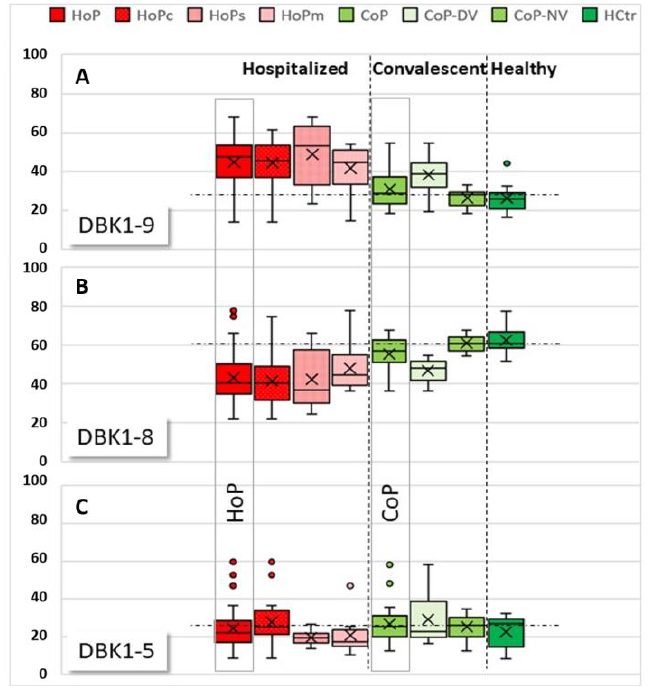
Figure 3. Boxplots of relative values for labeled bradykinin DBK1-9 ( A ) and its cleavage products, DBK1-8 ( B ) and DBK1-5 ( C ), for samples of the hospitalized patients (HoP) in comparison to conva- lescent (CoP) and healthy (HCtr) probands. Subgroups: HoPc: critical disease, HoPs: severe disease, HoPm: moderate disease, CoP-NV: CoP subgroup, where NRA results fell within the range detected in healthy probands, CoP-DV: CoP subgroup where NRA results deviated from the values measured in healthy people. The vertical dashed lines separate the groups HoP, CoP, and HCtr, the horizontal dotted lines indicate the median in the CoP-NV reference cohort for improved visualization. DBK1-9 values were higher in HoP than in HCtr and CoP-NV, indicating reduced DBK degradation and thus lower protease activity in COVID-19. DBK1-8 values were lower in HoP due to reduced CPN activity. DBK1-5 deviated to higher values in HoP and two convalescent patients (CoP-DV). DBK1-5 correlated with disease severity; values shot up in critical disease.